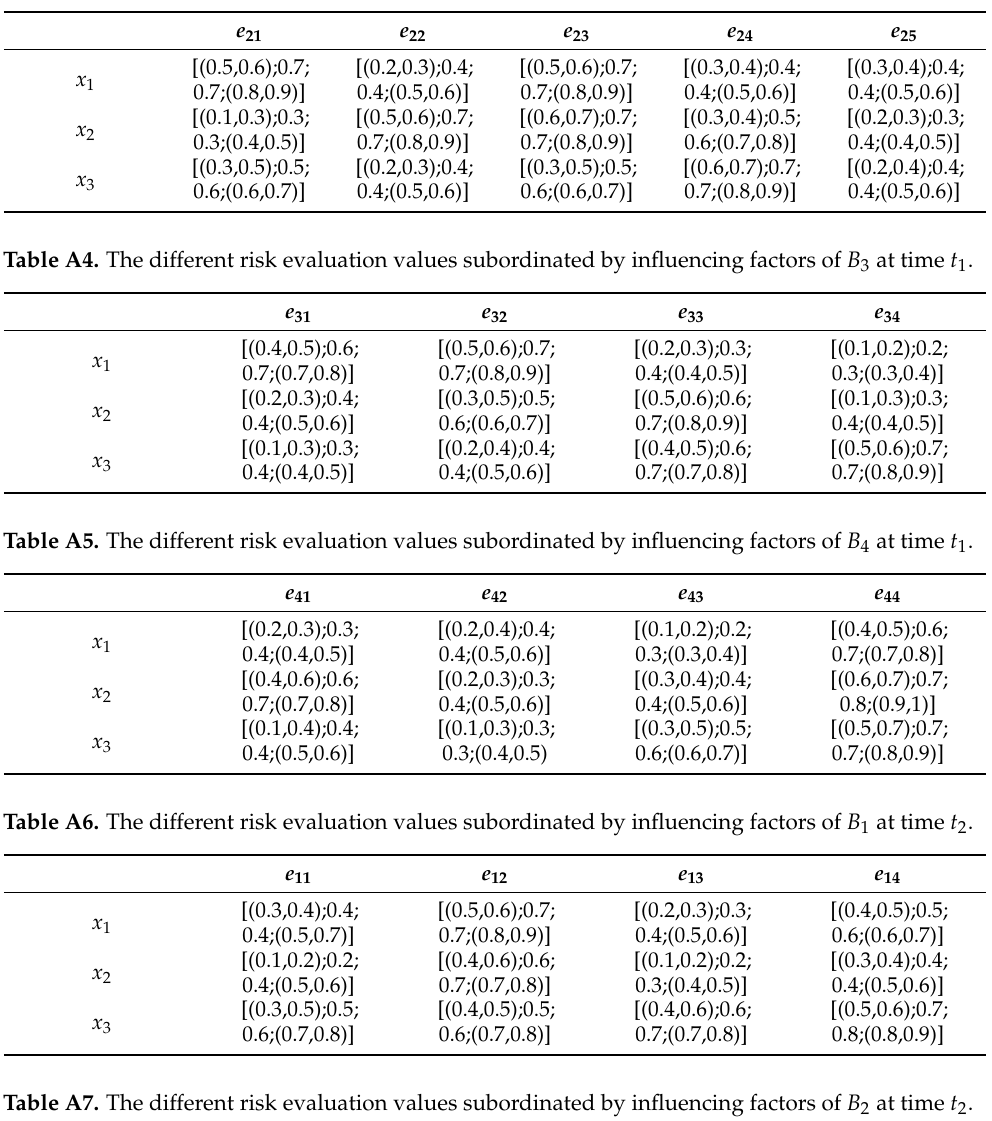
Table A3. The different risk evaluation values subordinated by influencing factors of B 2 at time t 1 .